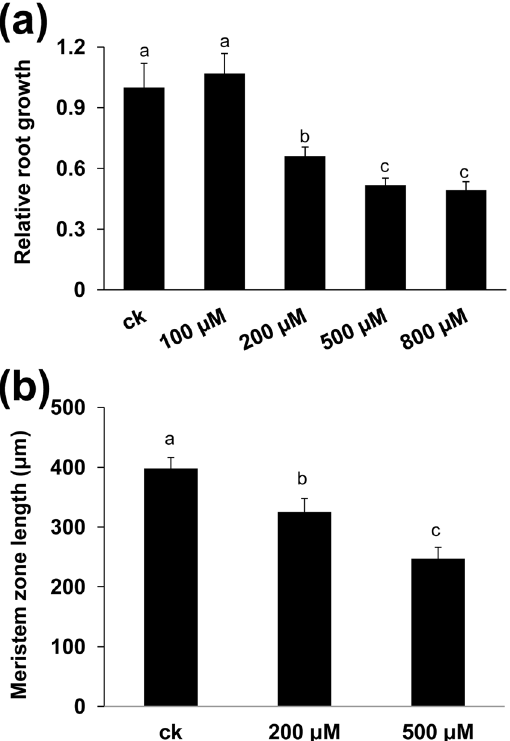
Figure 1. NaHS treatment inhibited PR growth. ( a , b ) Five-day-old wild-type seedlings grown in 1/2 MS medium were treated with 100–800 μ M NaHS for 2 d, and ( a ) PR growth and ( b ) the length of the meristem zone were measured after treatment. ck, untreated control. n = 60. Error bars represent ± SD. Different letters indicate significantly different values (P < 0.05 by Tukey’s